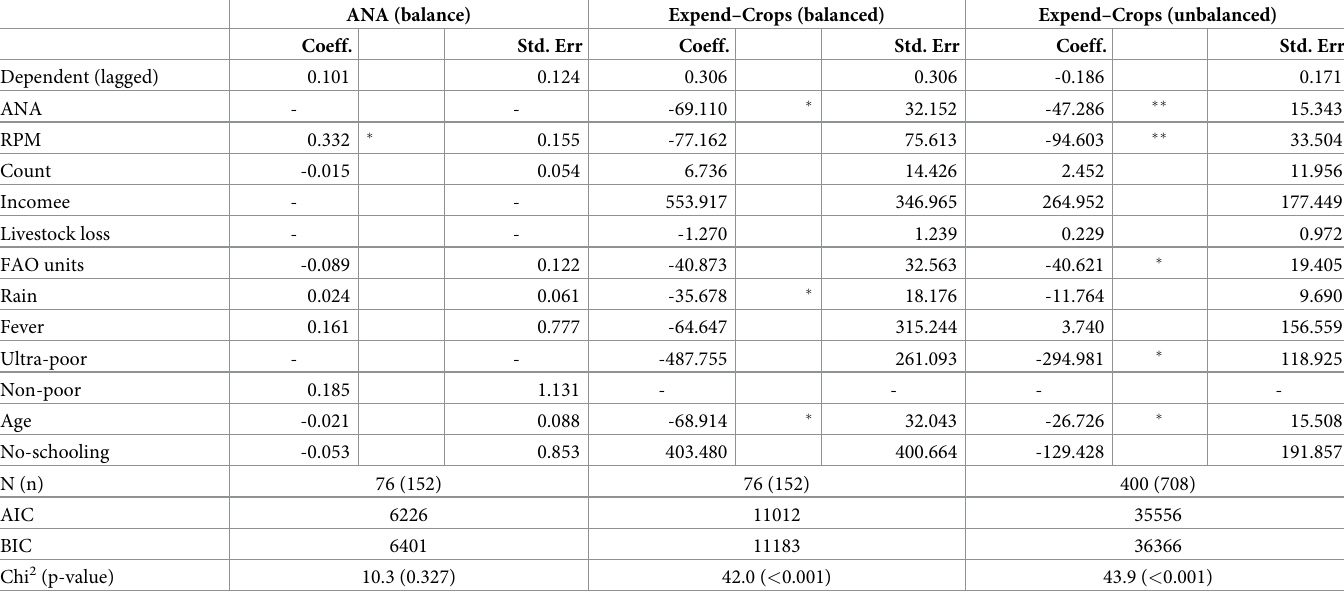
Table 4. Heuristic use and crop expenditure–balanced and unbalanced datasets.